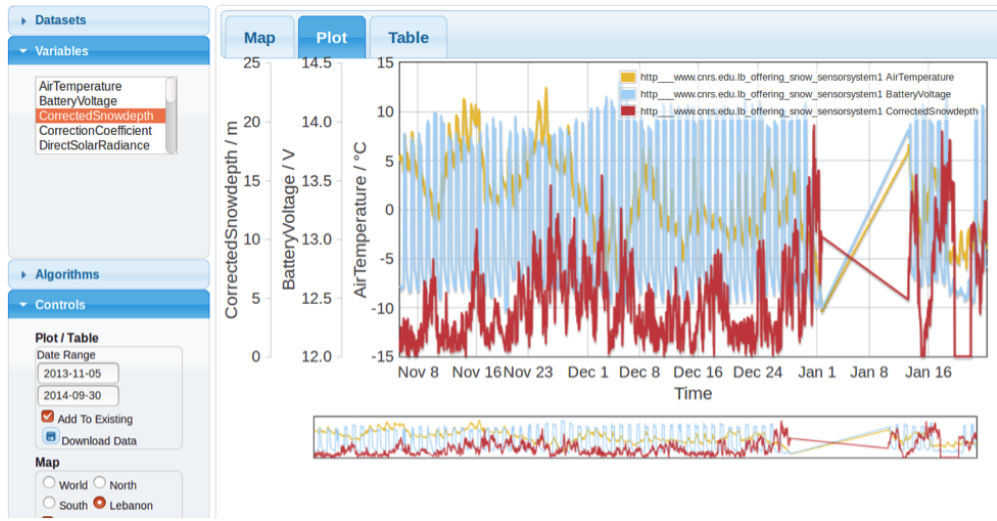
Figure 18. Intra-base data crossing